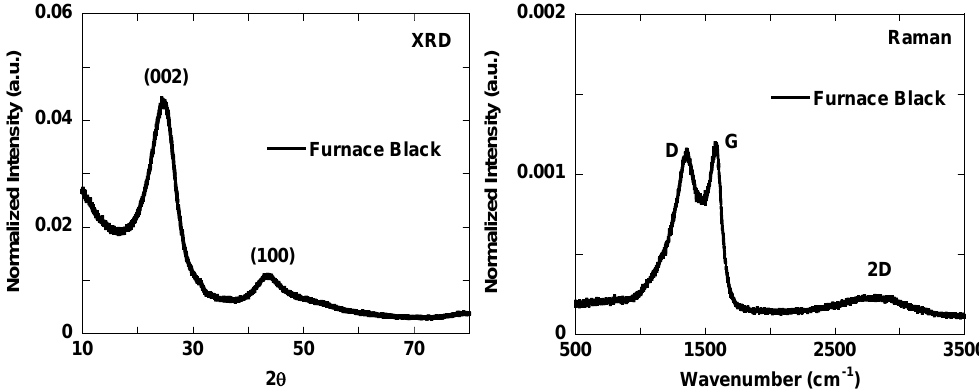
Figure 6. Illustrative examples of XRD and Raman spectra of carbon blacks. Table 1. Lattice parameters from X-ray diffraction.